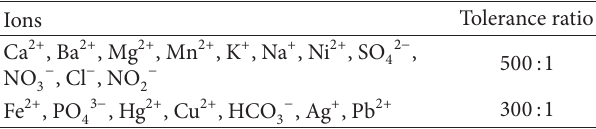
Table 3: Influence of foreign ions.